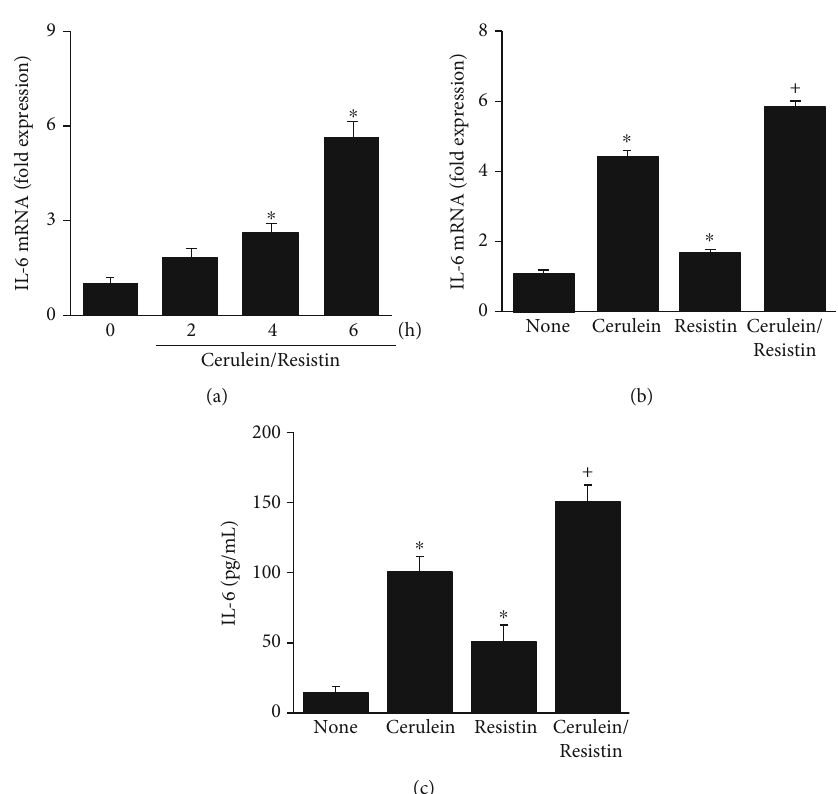
Figure 3: Resistin enhances the cerulein-induced IL-6 expression in AR42J cells. (a) The cells were stimulated with cerulein/resistin for the indicated times. (b, c) The cells were stimulated with cerulein in the presence and absence of resistin for 6h (for mRNA level (b)) or 24h (for protein level (c)). The mRNA level of IL-6 was determined by real-time PCR analysis and normalized to β -actin (a, b). The protein level of IL- 6 in the media was determined by enzyme-linked immunosorbent assay (ELISA) (c). Data are expressed as the mean ± S : E : of three di ff erent experiments. ∗ p < 0 : 05 vs. 0min (a) or none (untreated cells; b, c); + p < 0 : 05 vs. cerulein (cells treated with cerulein